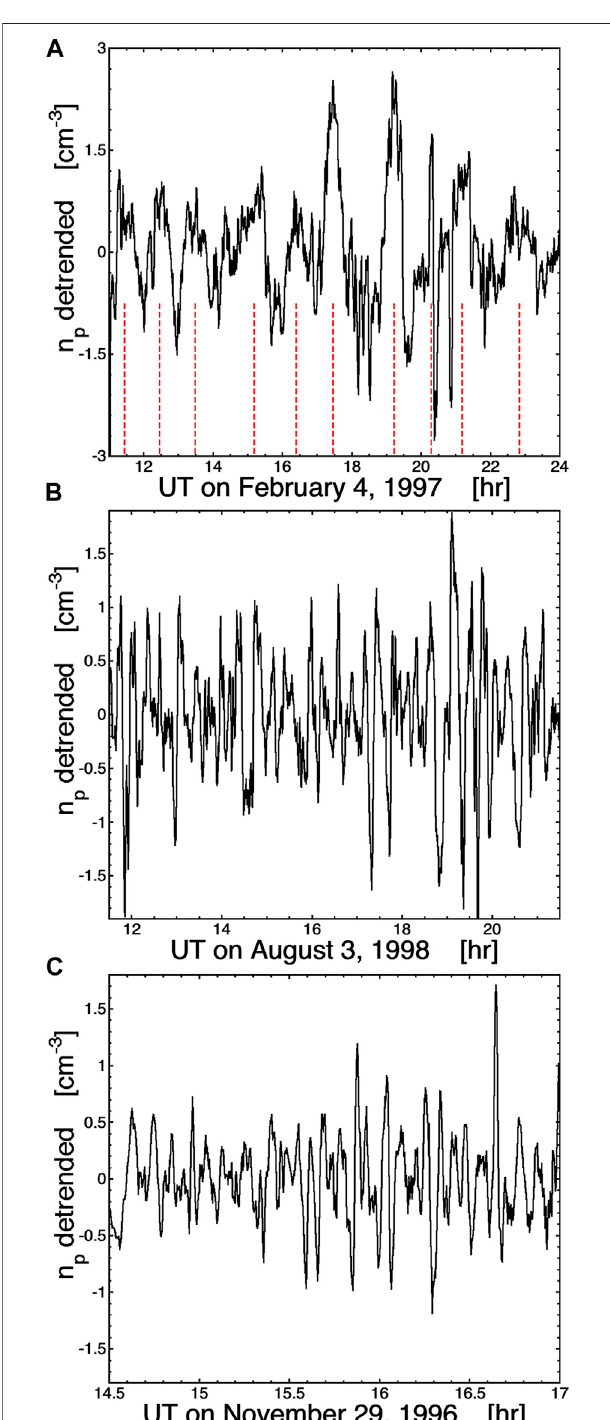
FIGURE 3 | The detrended number density of the solar wind at 1 AU is plotted as a function of time on three different days when periodic density structures are seen by the WIND spacecraft. The periodicities are approximately 70 min in panel (A) , 18 min in panel (B) , and 7 min in panel (C)